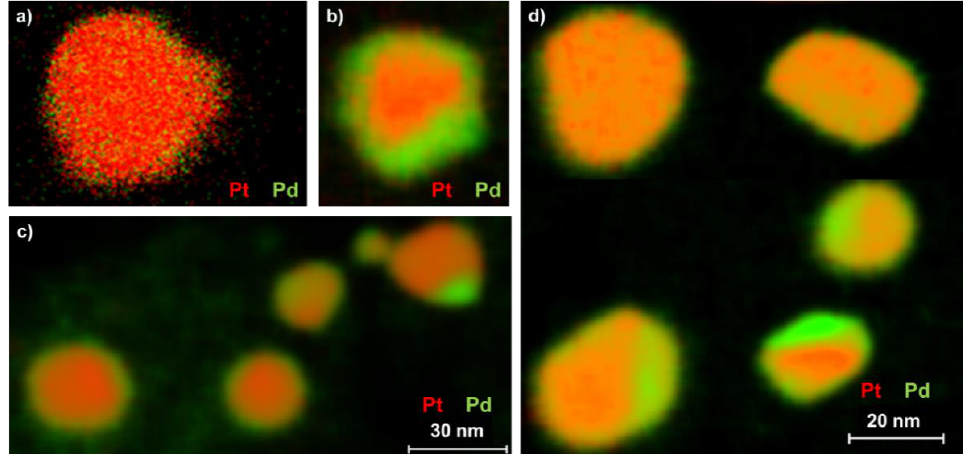
Figure 4. Energy dispersive X-ray spectroscopy (EDXS) scan of Pt-Pd particles in the fresh state ( a ) and after aging for 1 h at 750 ◦ C ( b ), 5 h at 750 ◦ C ( c ) and 16 h at 750 ◦ C ( d